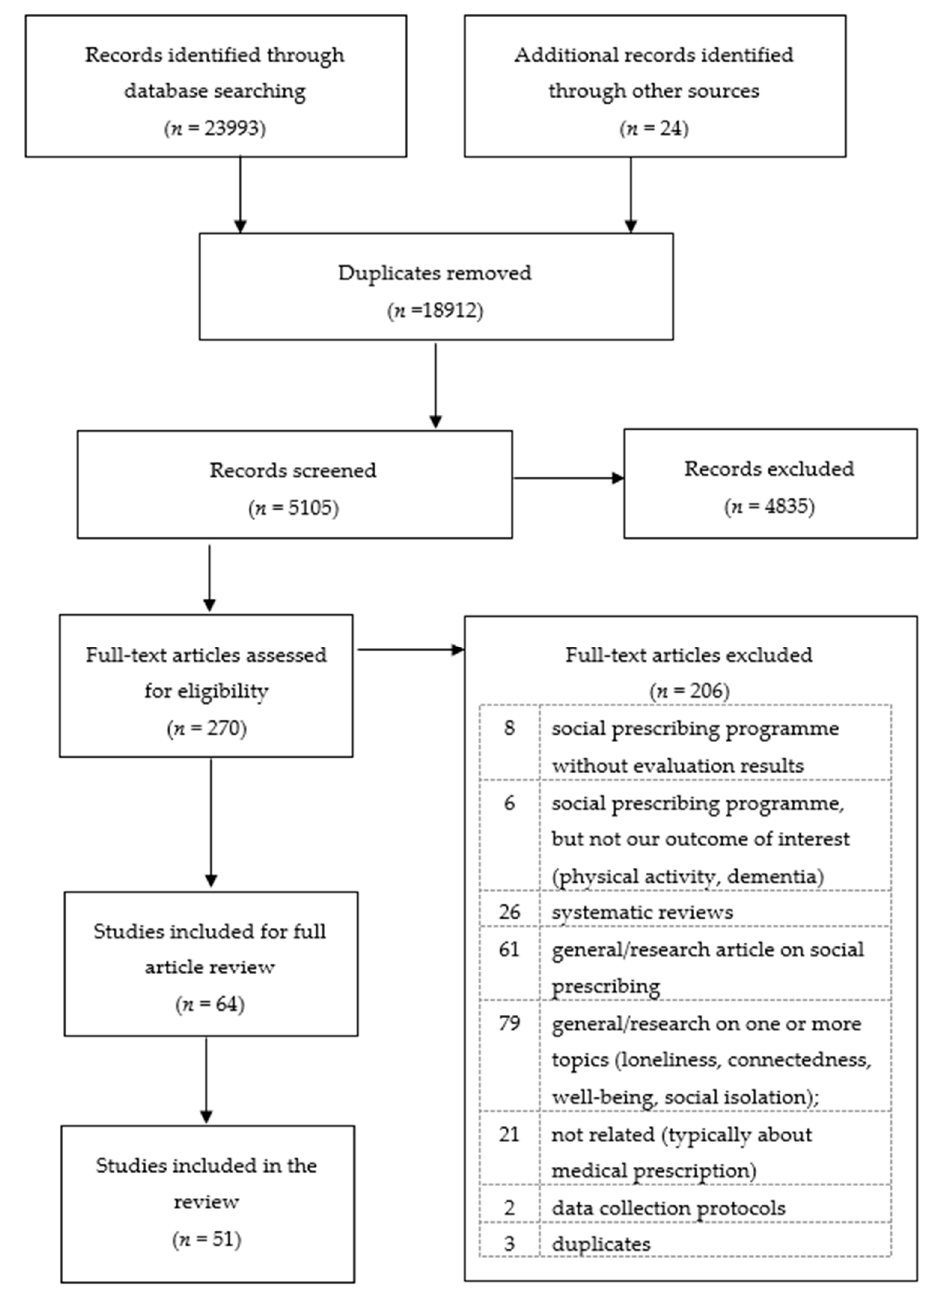
Figure 2. PRISMA flow diagram of the systematic review of social prescribing programmes designed to address loneliness, social isolation, well-being, and connectedness across the globe, 2000–2020.